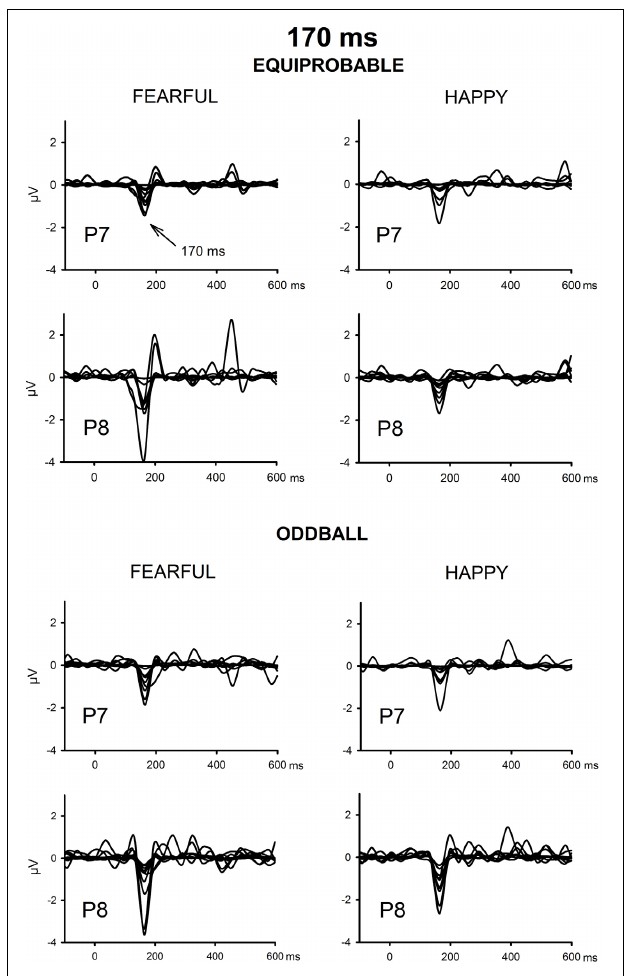
FIGURE 5 | Back-projected 170-ms components for each participant. Differential response waveforms (emotional minus neutral) at P7 and P8 electrodes are drawn separately for fearful and happy faces and for oddball condition and equiprobable condition groups.